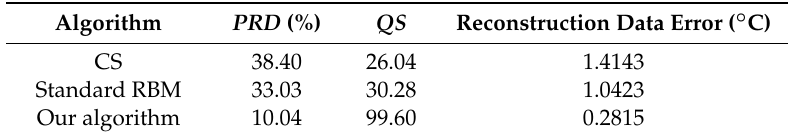
Table 1. Compression performance comparison.